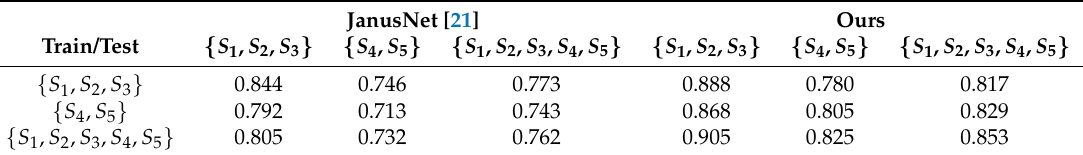
Table 7. Face verification accuracy on the Pandora splits. As reported in Section 4.1, S 1 , S 2 , S 3 sequences contain constrained movements, while subsets S 4 , S 5 consist of complex movements and